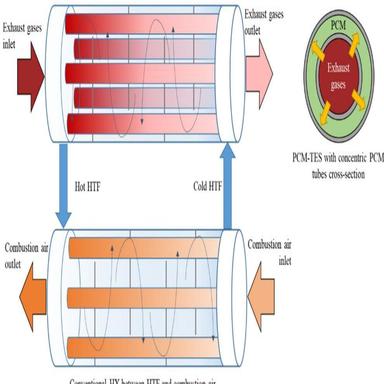
Diagram of a PCM-TES system formed by two HX modules connected by a HTF.